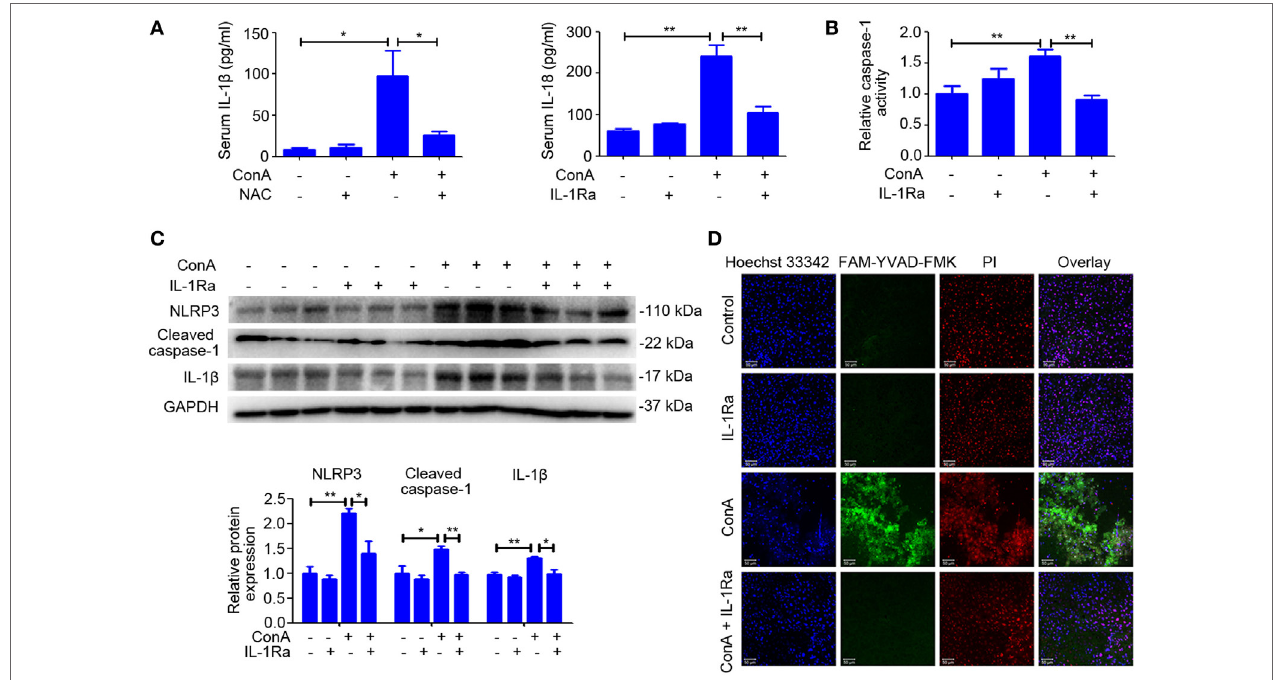
FigUre 5 | Recombinant human interleukin-1 receptor antagonist (RhIL-1Ra) ameliorated ConA-induced NOD-like receptor protein 3 (NLRP3) inflammasome activation and pyroptosis. (a) BALB/c mice ( n = 6 for each group) were pretreated with rhIL-1Ra before ConA injection, and samples were extracted at 12 h post ConA treatment. Serum IL-1 β and IL-18 were detected by ELISA. (B) Liver homogenates were subjected to caspase-1 activity assay. (c) Western blot of NLRP3, Cleaved caspase-1, and IL-1 β in the livers. GAPDH acted as a loading control. Each lane represented a separate animal. Results were obtained from three experiments. Quantification of protein expression were obtained by Image J software. (D) Caspase-1 positive death cells staining were observed by confocal microscopy. FAM-YVAD-FMK (green), propidium iodide (red), Hoechst 33342 (blue). The data were presented as means ± SD (Student’s t -test, * p < 0.05, ** p <